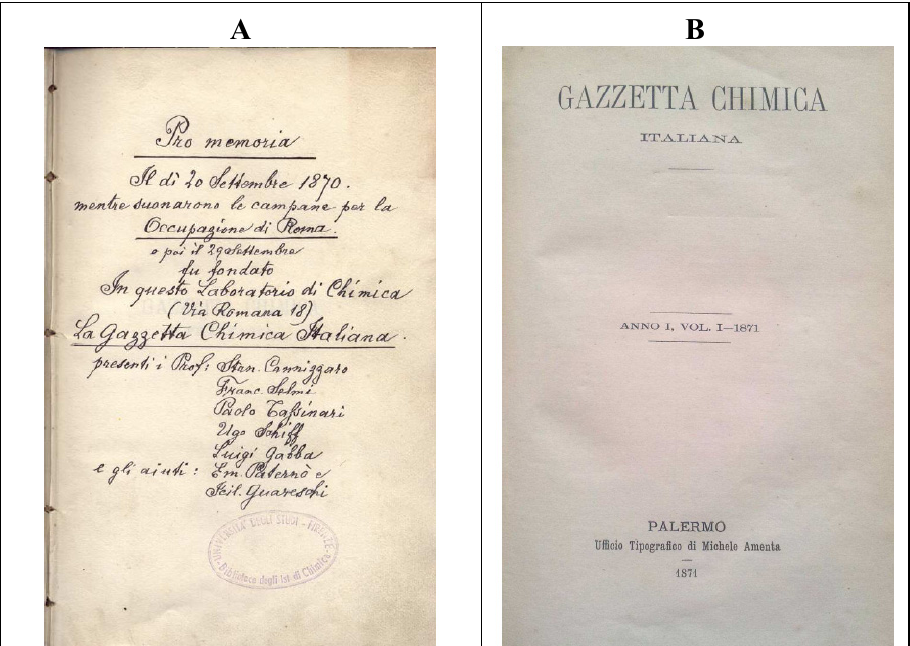
Figure 2. The founding act of the Gazzetta Chimica Italiana (Italian Chemical Gazette) (29 September 1870, A ) and the frontispiece of its first issue (31 March 1871, B